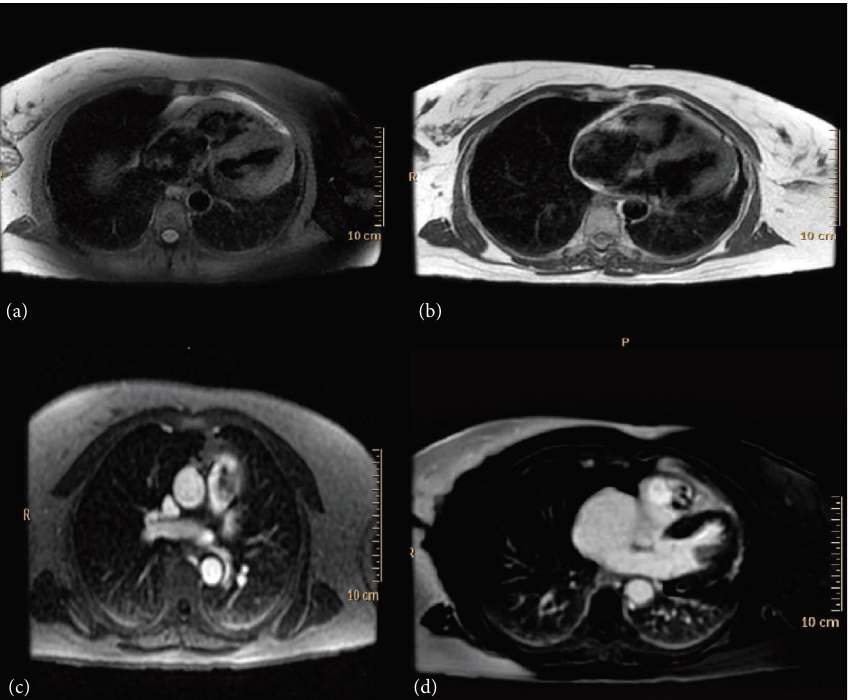
Figure 4: Cardiac magnetic resonance imaging shows RV mass. (a) shows RV mass, which is hypointense on T1 sequence, isointense on T2 (b), (c) shows poor frst pass perfusion, and (d) shows heterogeneous uptake on late gadolinium enhancement. Abbreviations: RV: right